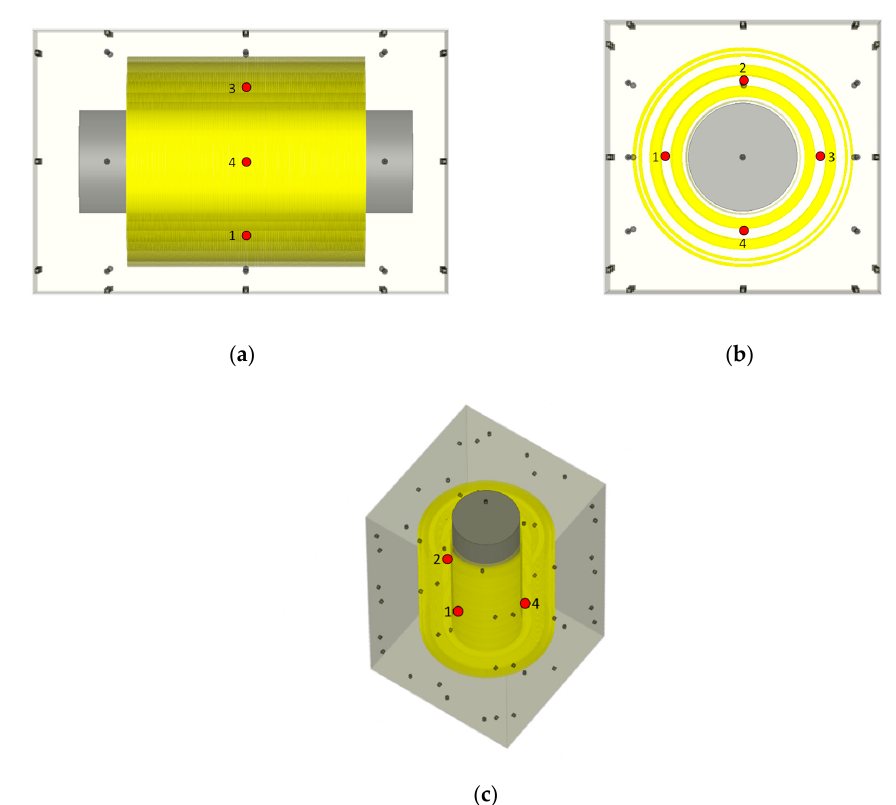
Figure 4. Simplified single-phase model with nine sensors on each face (gray circles) and four partial discharge (PD) sources (red circles) inside the winding ( a ) Side view; ( b ) Top view; ( c ) Isometric view. The second setup represents a complete transformer model which consists of 18 possible PD source locations with 12 inside and six outside the winding, as shown in Figure 5. The six sources outside the windings correspond to the locations of the lead exits. Considering a single phase (U, V, or W), the four sources inside the winding are numbered from 1 to 4, and the two sources corresponding to the lead exits are numbered 5 and 6.